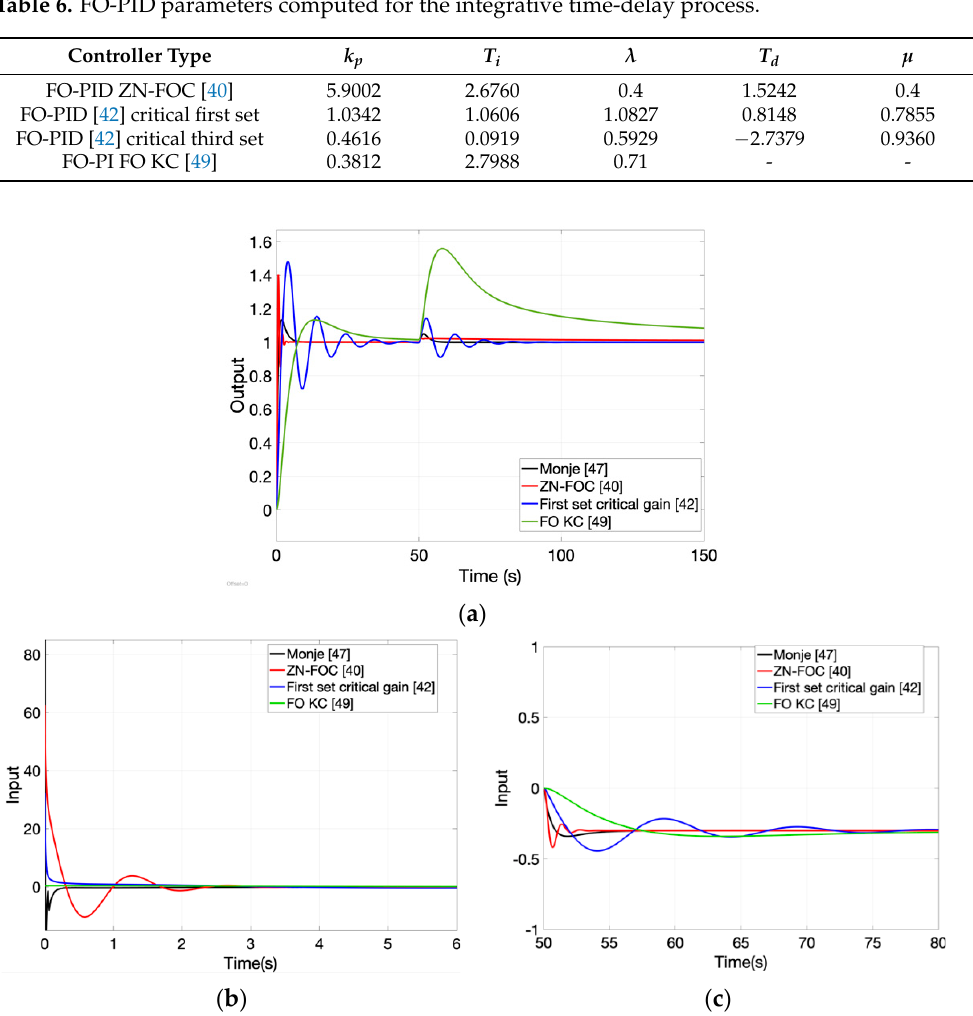
Table 6. FO-PID parameters computed for the integrative time-delay process.